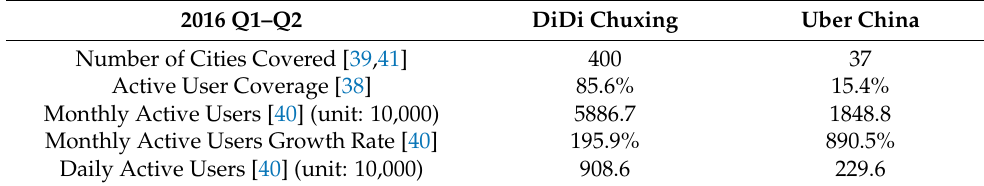
Table 1. Comparison of coverage between DiDi Chuxing and Uber China